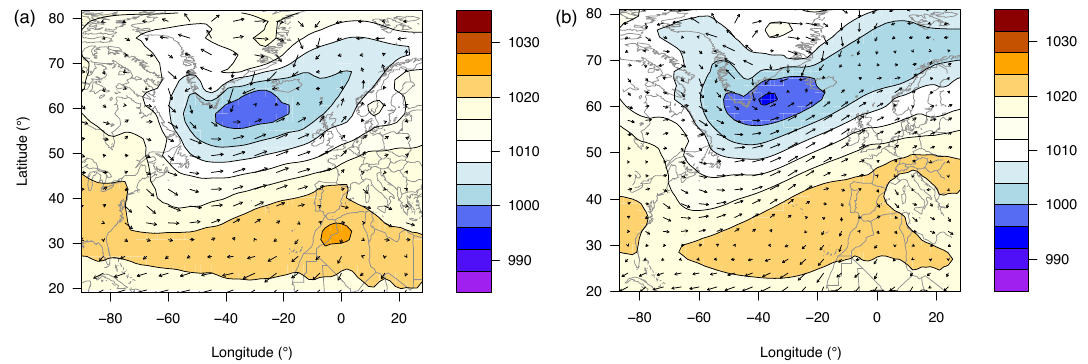
Fig. 6. (a) ESSENCE SLP climatology in hPa (45900 entries) for DJF 1950–1980, (b) ERA-Interim SLP climatology (1 . 5 ◦ × 1 . 5 ◦ ) for DJF over the 30yr period